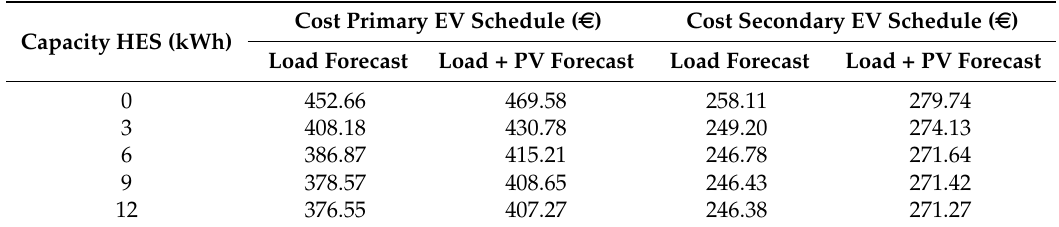
Table 3. Comparison: Load forecast and Load + PV forecast.